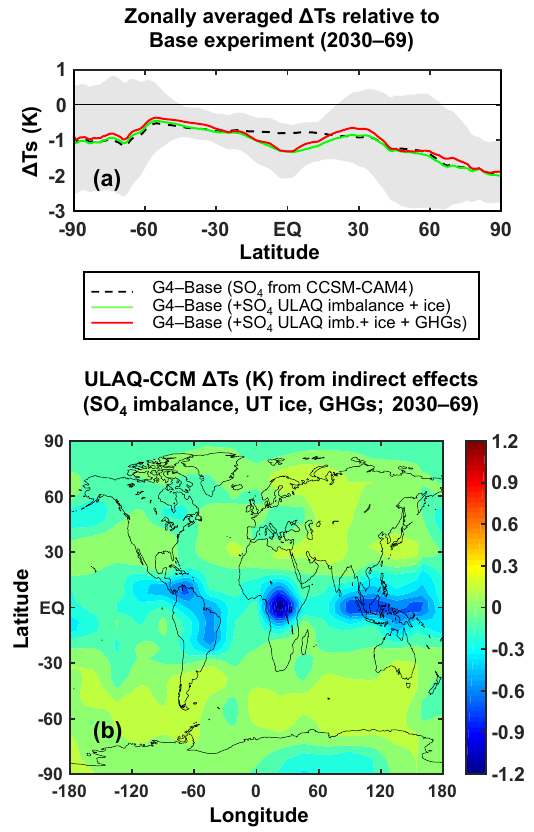
Figure 6. (a) Zonally averaged T s anomalies G4-RCP4.5 (K), un- der different conditions for the G4 perturbed case (time-averaged over the years 2030–2069): from the atmosphere–ocean coupled model CCSM-CAM4 (black dashed line); as above, but adding the T s anomalies in the ULAQ-CCM model with online coupling of cirrus ice changes and the SO 4 imbalance between CCSM-CAM4 and ULAQ-CCM (green line); as above, but also adding the T s anomalies in the ULAQ-CCM model with online coupling of GHG changes (red line) (see text and legend). The shaded area represents ± 1 σ of the zonally averaged T s over the 40-year period. (b) Lat– long distribution of the T s anomalies (K) calculated online in the ULAQ-CCM model considering cirrus ice changes, the SO 4 imbal- ance between CCSM-CAM4 and ULAQ-CCM and GHG changes (time-averaged over the years 2030–2069).